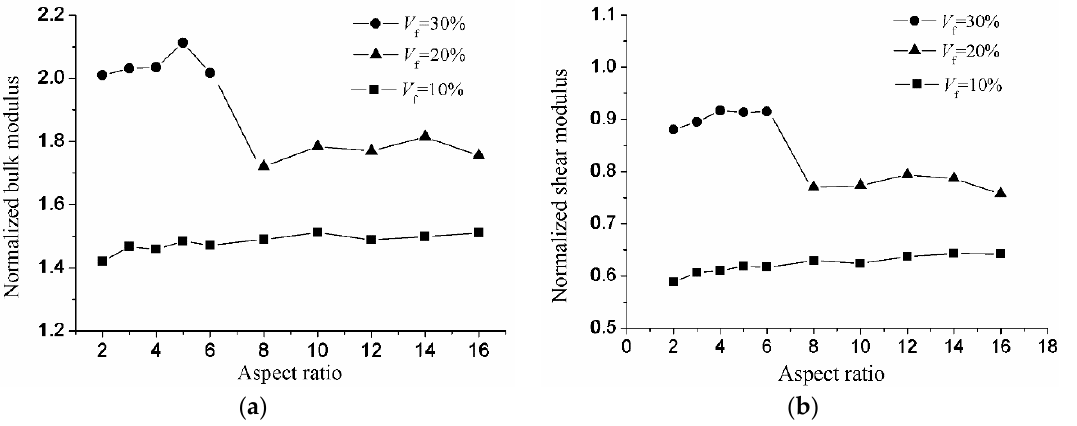
Figure 10. The variation of normalized modulus with the aspect ratio for the volume fraction being fixed: ( a ) bulk modulus; ( b ) shear modulus.